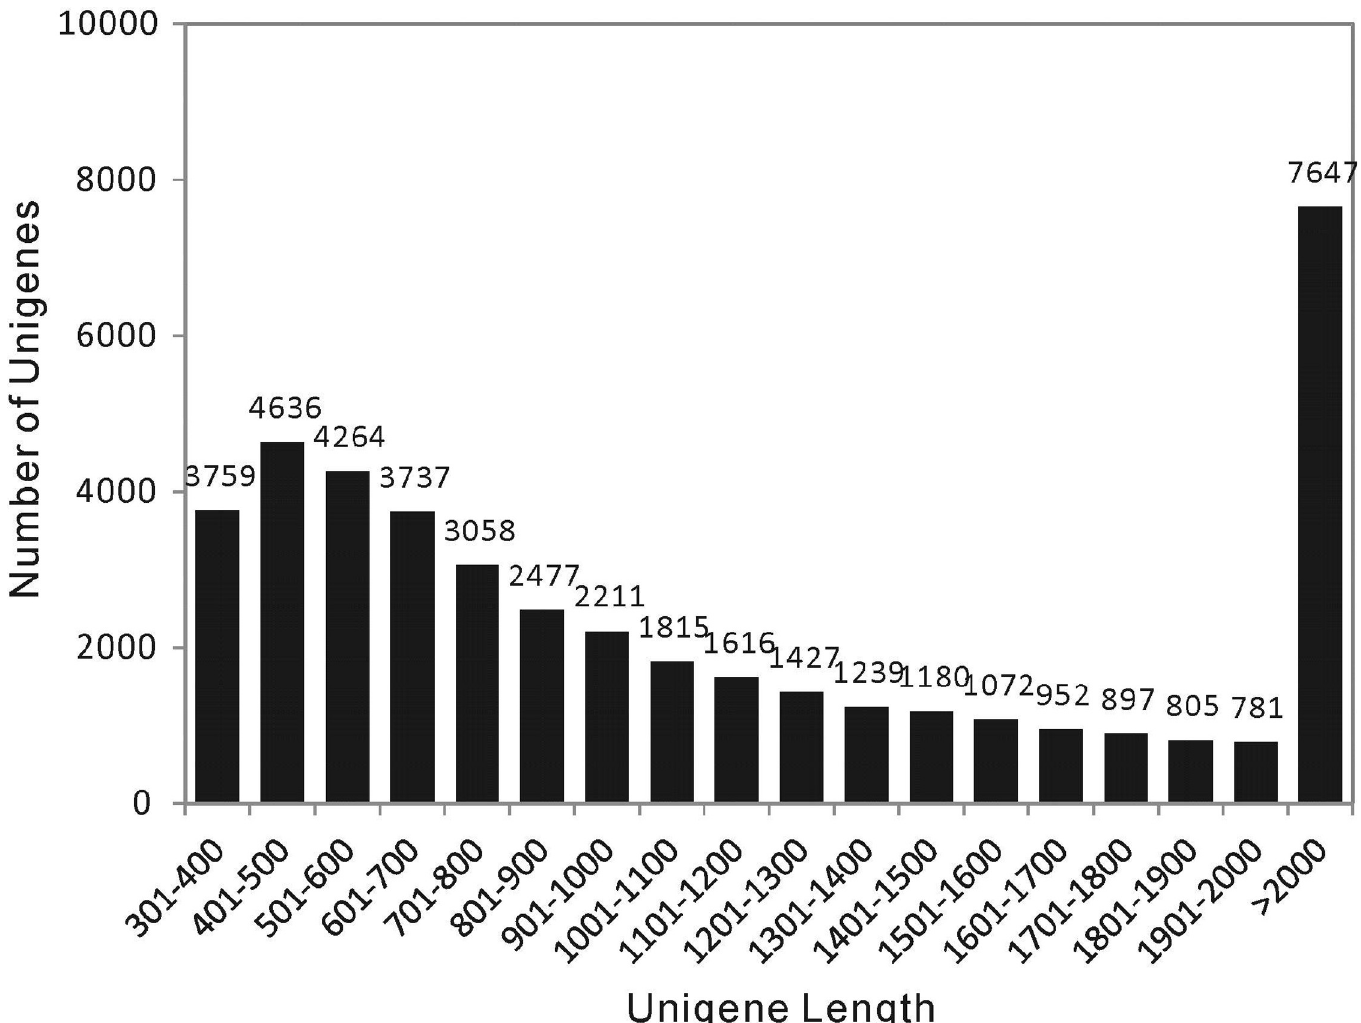
Fig 2. Sequence length distribution of the unigenes in the L . ruthenicum fruit transcriptomes. The x -axis indicates unigene length interval from 300 bp to > 2,000 bp. The y -axis indicates the unigenes number of each given sequence length.